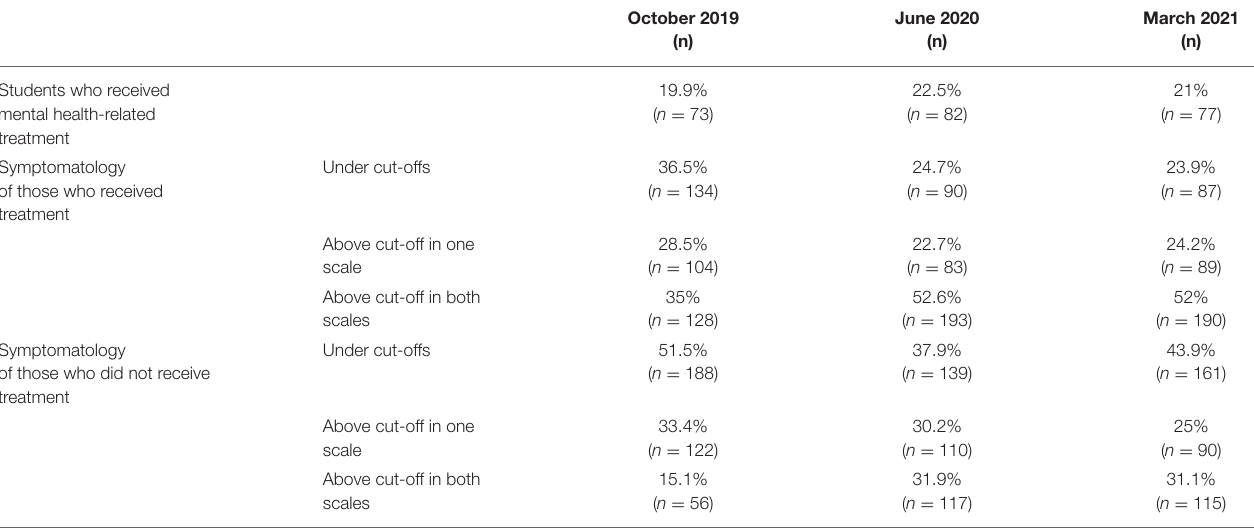
TABLE 3 | Global treatment proportions throughout time and according to clinical